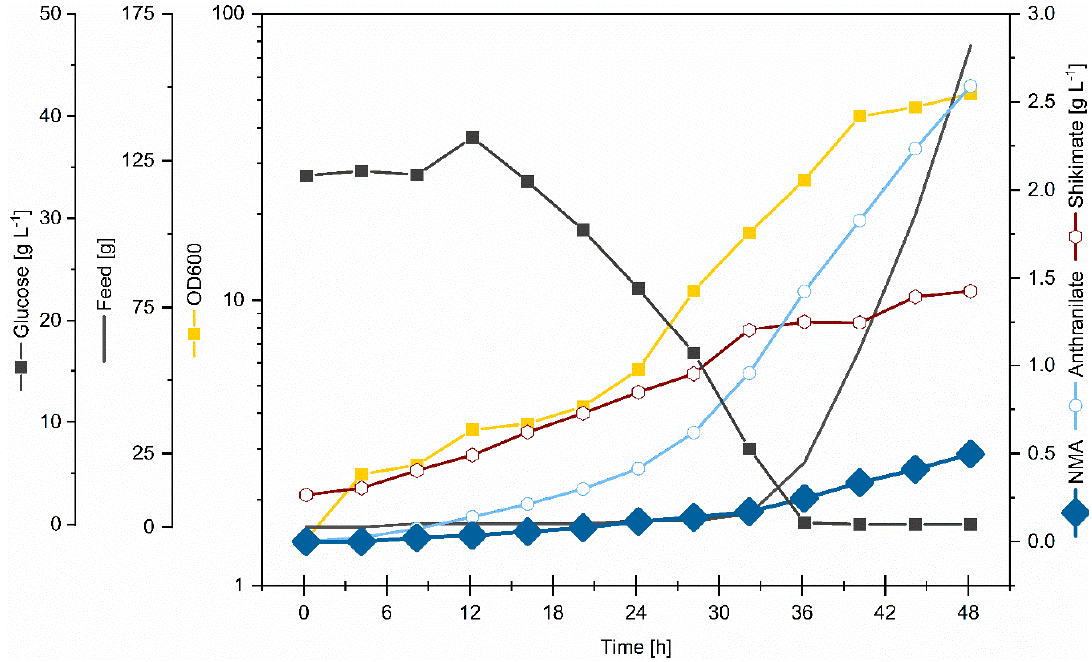
Figure 6. NMA production by C. glutamicum strains NMA105 in bioreactors operated in fed-batch mode. The cultivation (initial volume of 2 L) was performed in minimal medium supplemented with 40 g·L -1 glucose (dark grey line with squares). The feed (dark grey line) contained 400 g·L − 1 glucose and 150 g·L − 1 (NH 4 ) 2 SO 4 . 1 mM IPTG was added for induction of gene expression during inoculation. OD 600 (yellow) and concentrations of anthranilate (light blue), shikimate (maroon), and NMA (dark blue) in the culture broth are depicted. One of two representative fermentations is shown.